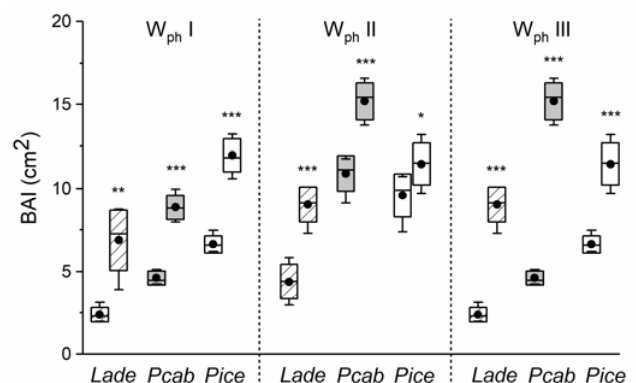
Figure 4. Comparison of mean basal area increment (BAI) of selected tree species ( Lade = Larix decidua ; Pcab = Picea abies ; Pice = Pinus cembra ) from subalpine sites at beginning and end of increasing air temperature during phase I (W ph I), phase II (W ph II) and during the whole study period (W ph III; cf. Figure1). Box and whiskers plot showing median (horizontal line) and mean (closed circle) ± standard deviation (box); whiskers extend to the 10th and 90th percentiles. Statistical significant differences between BAI at the beginning and end of warming phases are indicated by asterisks (* p ≤ 0.05, ** p ≤ 0.01, *** p ≤ 0.001). Table 3. Increase in basal area increment (cm 2 ) during selected phases of climate warming (W ph I-III). Mean values ± standard deviations are shown. Statistically significant differences of mean values between species and W ph I and W ph II are indicated by different letters ( p ≤ 0.05).